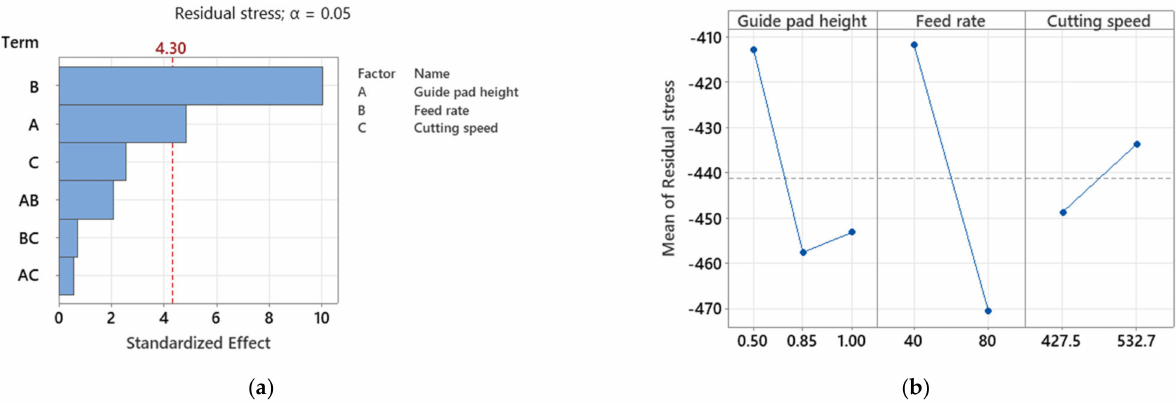
Figure 15. Pareto chart of the standardized effects for the residual stress ( a ) and main effects plot for the residual stress ( b